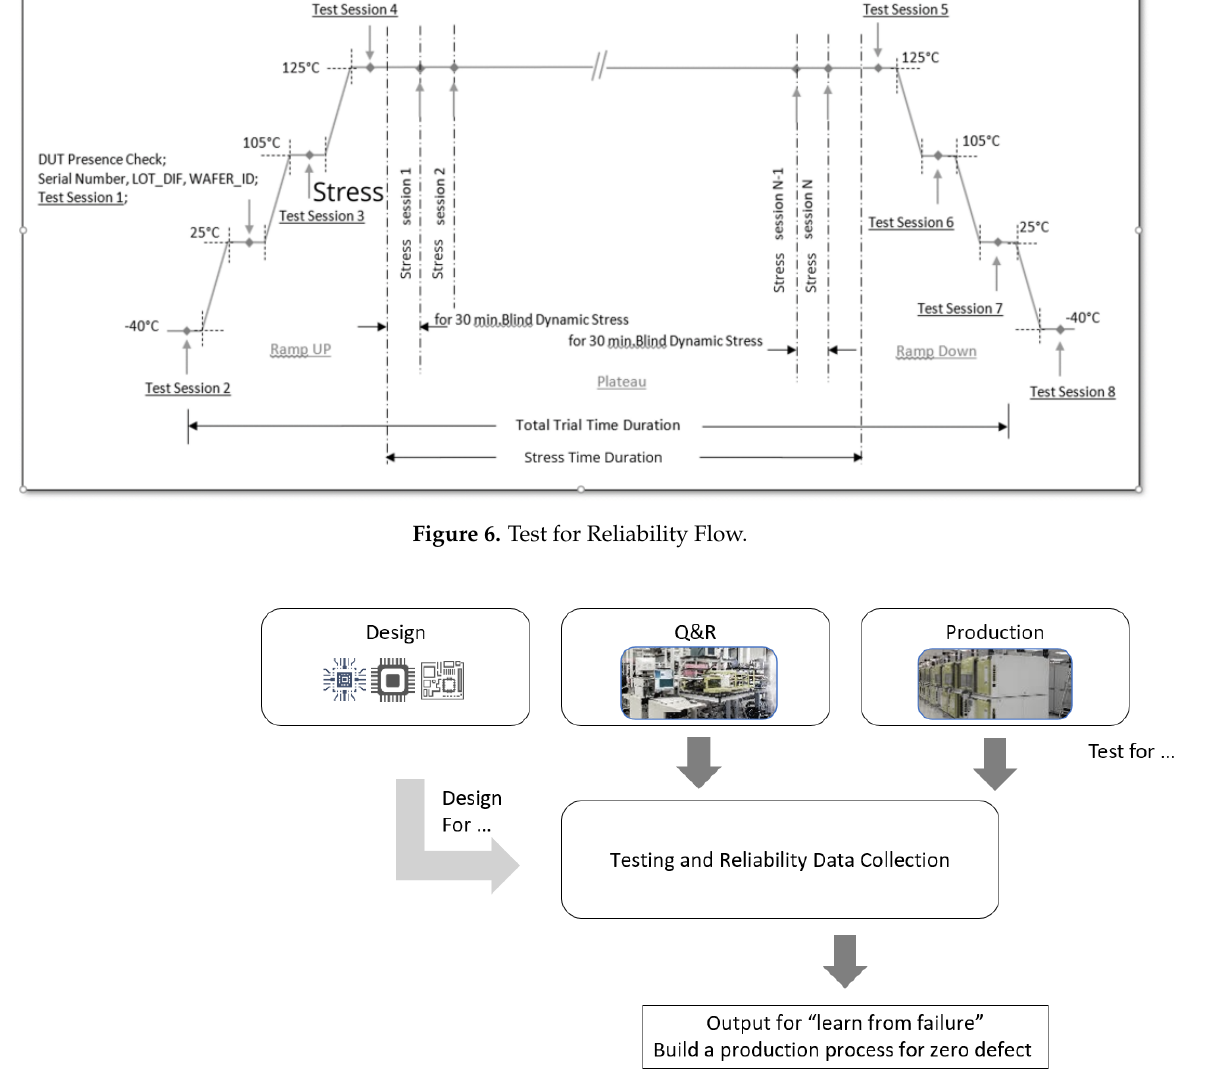
Figure 7. The collection of test and reliability data is at the center of the process.